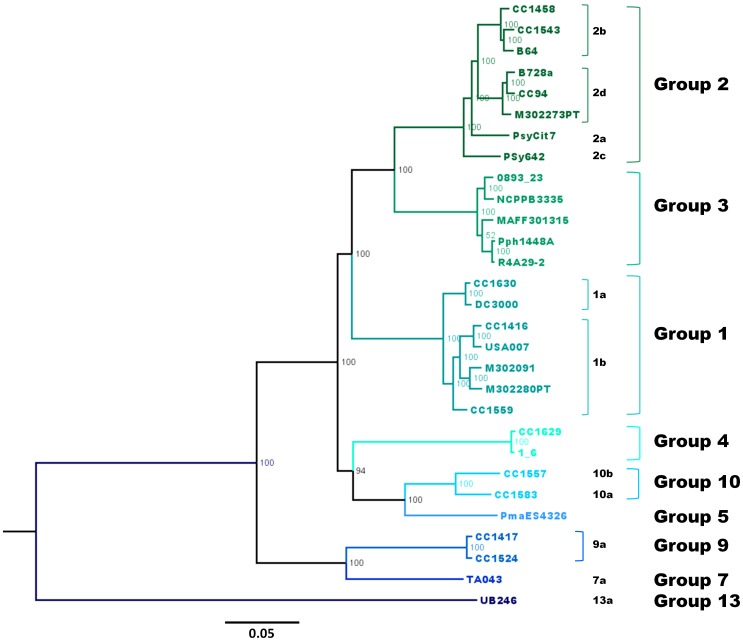
Bayesian phylogeny of the core genome of 29 P. syringae strains.An un-rooted tree was constructed on 107 open reading frames (64,000 bp) common to 29 P. syringae strains. Bootstrap values are indicated at each node and strain names are indicated at tree branches. Phylogroup and clade names are also indicated in the tree.